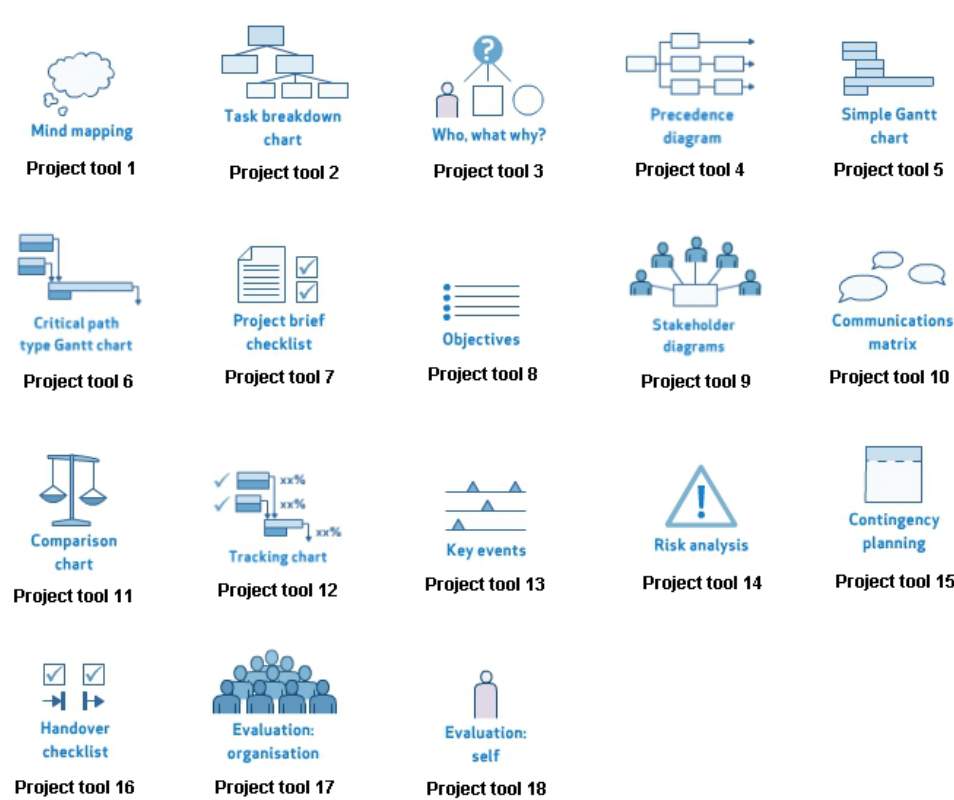
Figure 14 . The project tools of Y Call Compendium case study